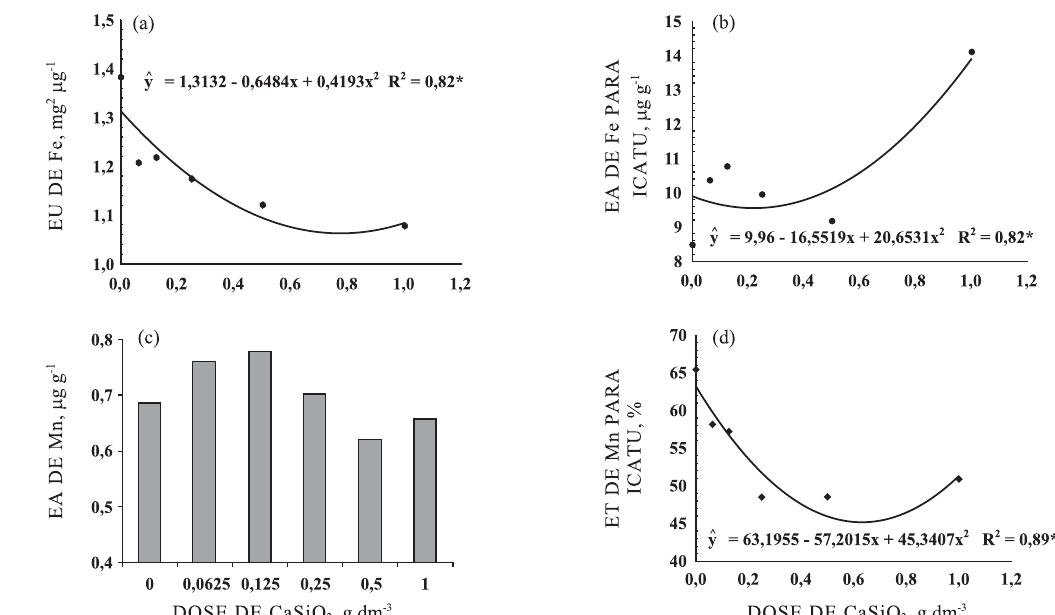
Figura 3. Eficiência de uso (EU) do ferro pelas mudas de cafeeiro independente da variedade (a); eficiência de absorção (EA) do ferro pela variedade Icatu (b); EA de Mn pelas mudas de cafeeiro (c) e eficiência de translocação (ET) de Mn pela variedade Icatu (d), em função das doses de silicato de cálcio (CaSiO aplicadas no substrato de